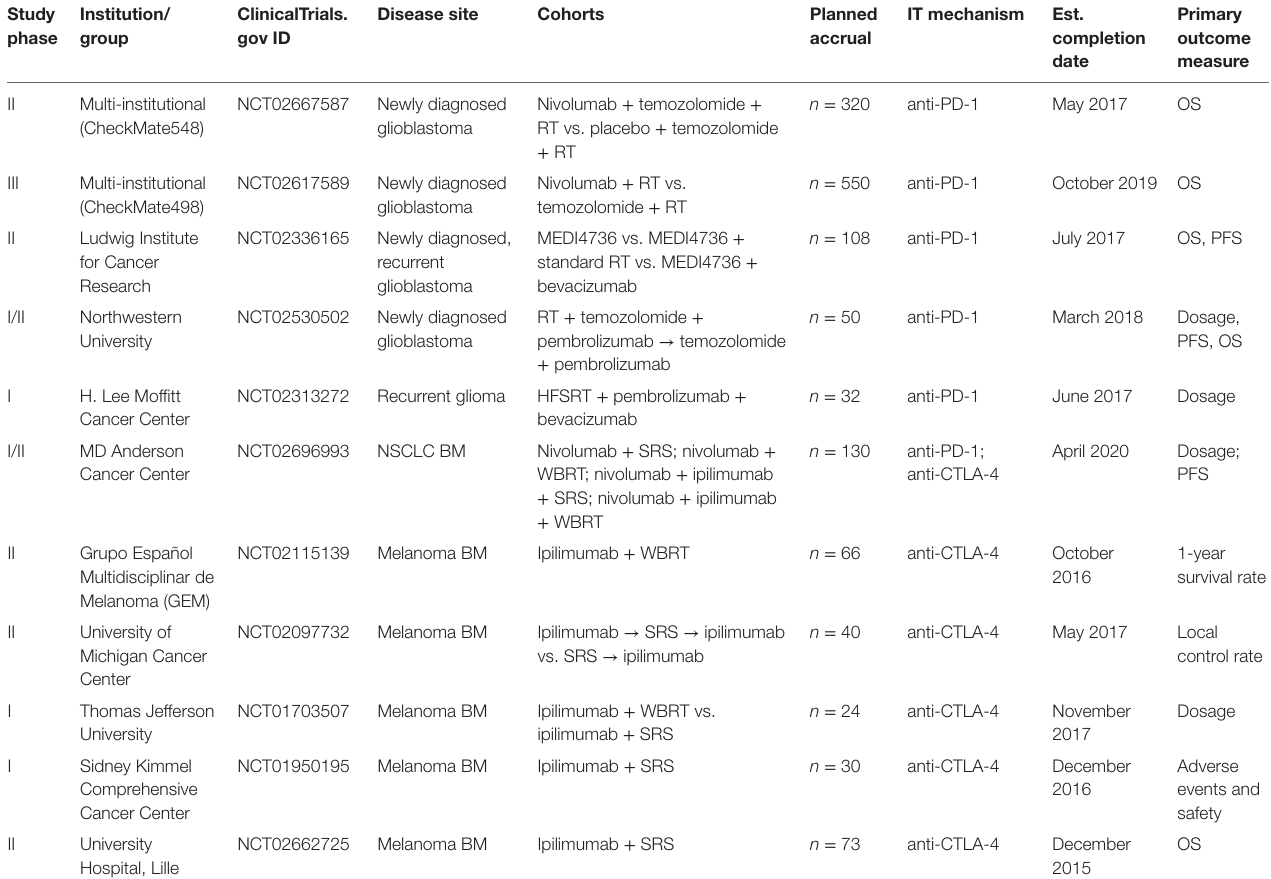
TABLe 1 | Current clinical trials of immunotherapy with radiation for primary and metastatic CnS